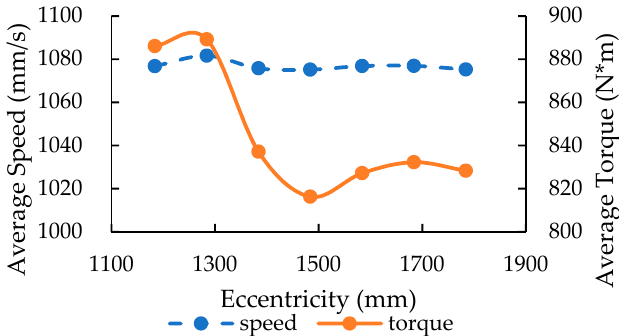
Figure 14. Relationship between speed, torque and eccentricity. With the increase of eccentricity, the average speed of the machine changes very little. When the eccentricity is 1284 mm, the maximum speed is 1081.6 mm/s. The average driving torque decreases first and then increases slowly with the increase of eccentricity. When the eccentricity is 1484 mm, the minimum driving torque of a single track is 816.26 N · m. Inserting this value of eccentricity into Equations (2) and (19), the theoretical driving resistance of the track is 5789 N. As the diameter of the driving wheel is 577 mm,